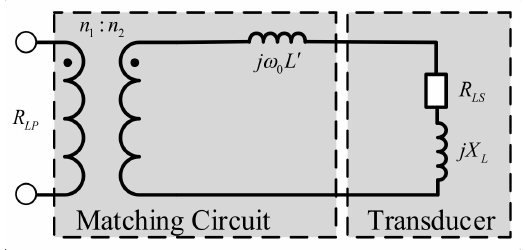
Figure 7. Matching